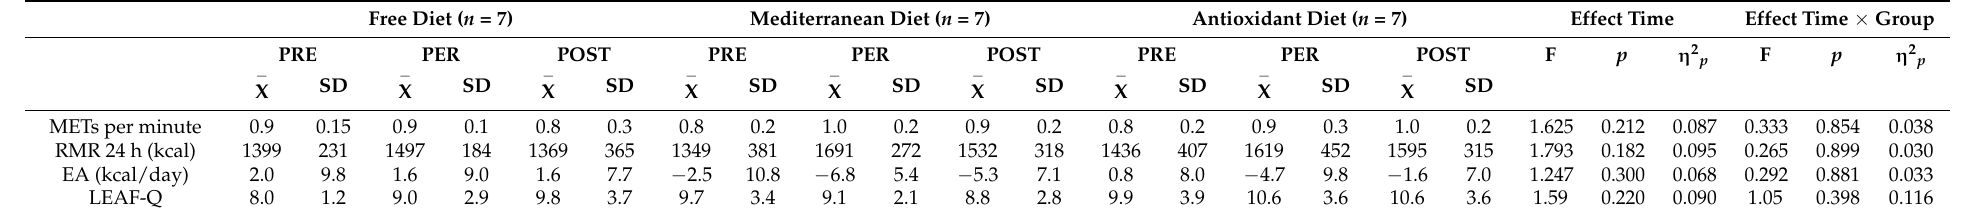
Table 2. Variables of energy availability and resting metabolic rate before, during and after the intervention in the free diet, Mediterranean diet, and antioxidant-rich diet groups.